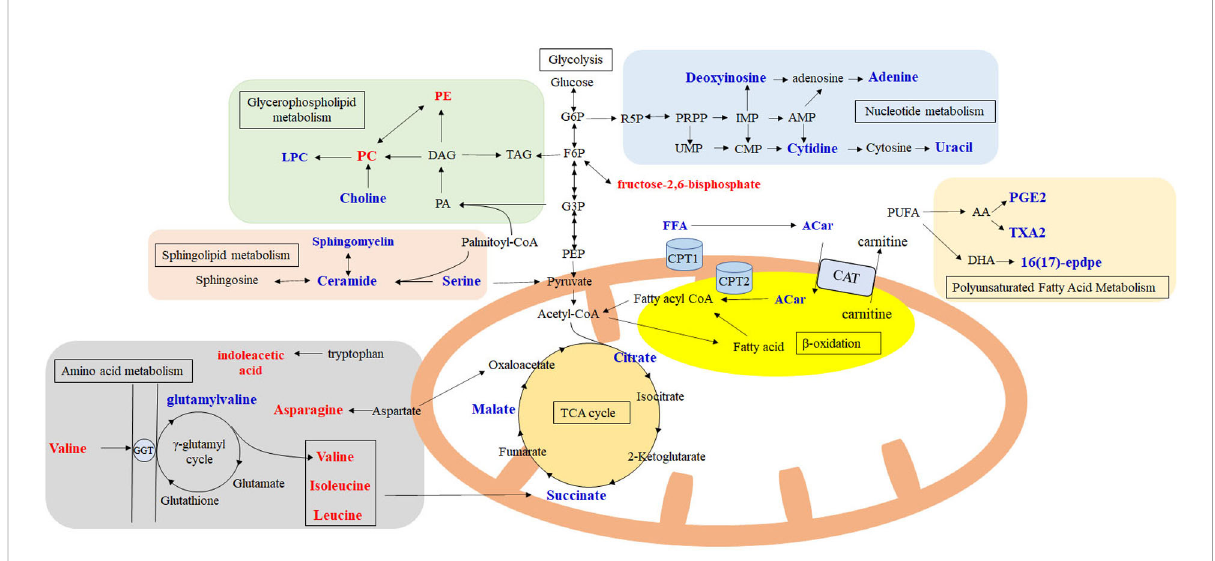
FIGURE 6 Altered of metabolites and metabolic pathways observed in patients with well response after dupilumab treatment. Differential metabolites are shaded in red or blue. Red represents evaluation after treatment and blue indicates a decrease after treatment. The average of all variants of lipids were calculated to represent the overall alteration of each subclass of lipid. Acar, Acylcarnitine; CAT, Carnitine Acytl Transferase; CPT1, carnitine palmitoyl transferase 1; CPT2, carnitine palmitoyl transferase 2; GGT, glutamyltransferase; FFA, Free fatty acid; LPC, Lysophophatidylcholine; PC, Phosphatidylcholine; PE, Phosphatidylethanolamine; PGE2, prostaglandins E2; TXA2, Thromboxane